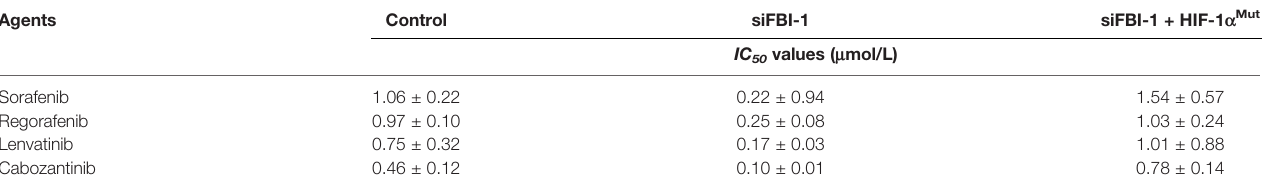
IC 50 values ( m mol/L)